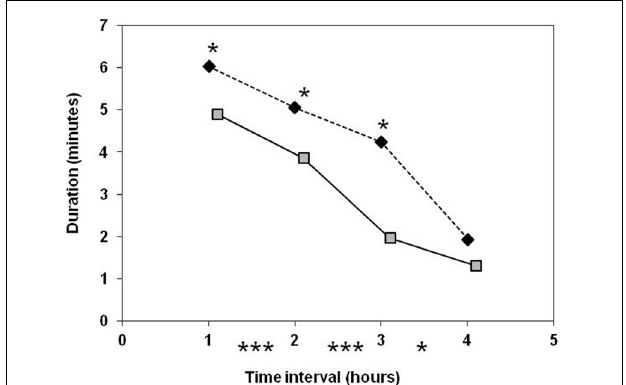
FIGURE 4 | Comparison of old-type sows ( (cid:2) ) and modern-type sows ( ) for rooting activity during the first 4h after the onset of farrowing. Significance levels below the X axis refer to differences between successive periods of time, obtained with both lines merged together. Significance levels reported on the graph above mean values refer to line differences: ∗ P < 0 . 05; ∗∗∗ P < 0 . 001.